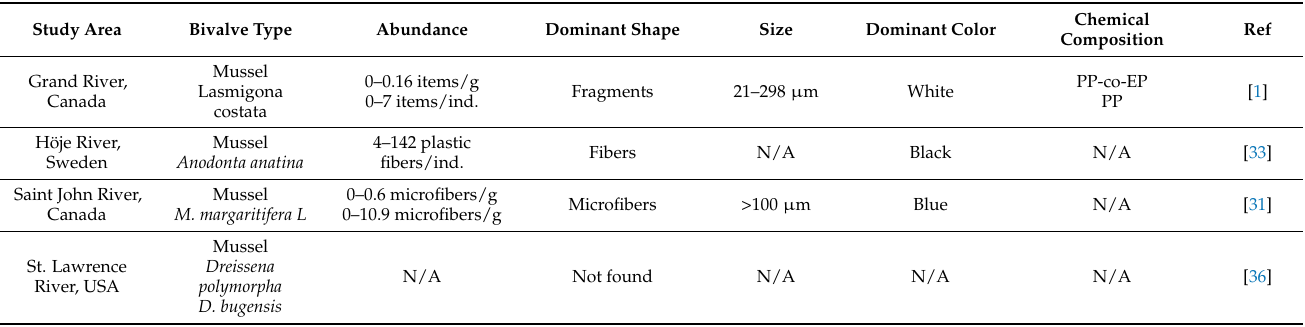
Table 1. A summary of abundance and characteristics of microplastics in bivalves from riverine